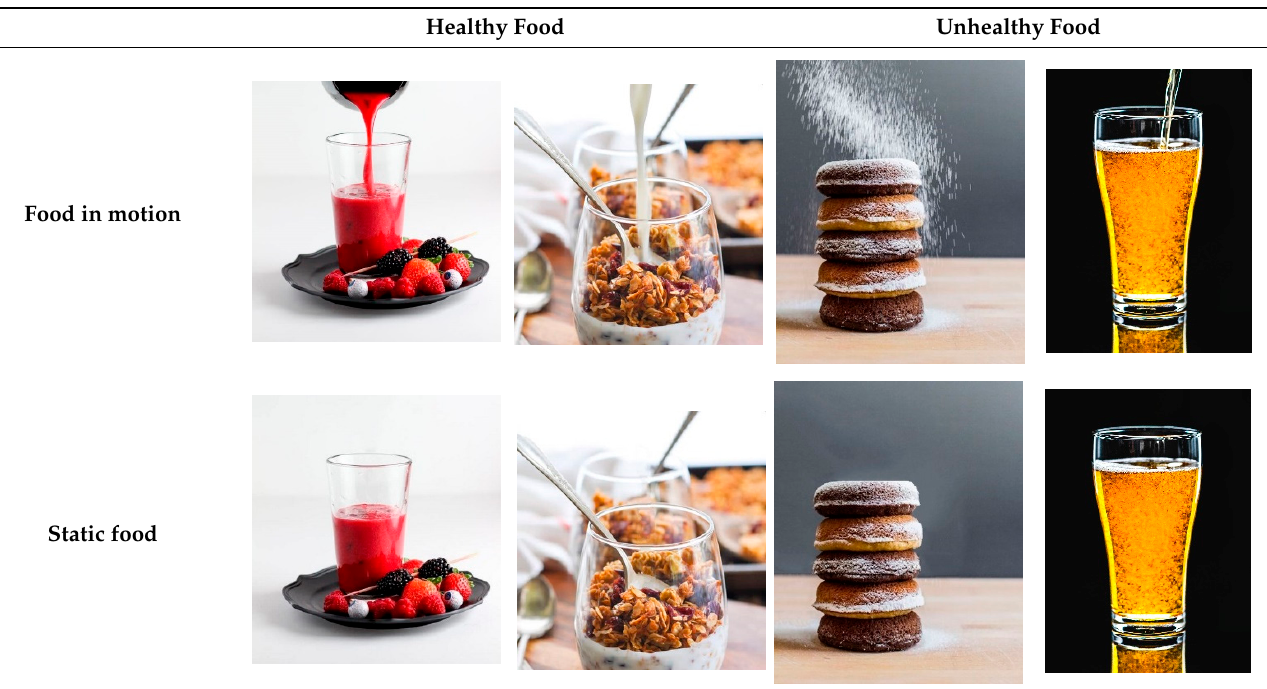
Table 4. Examples of the food stimuli used in Study 2a.